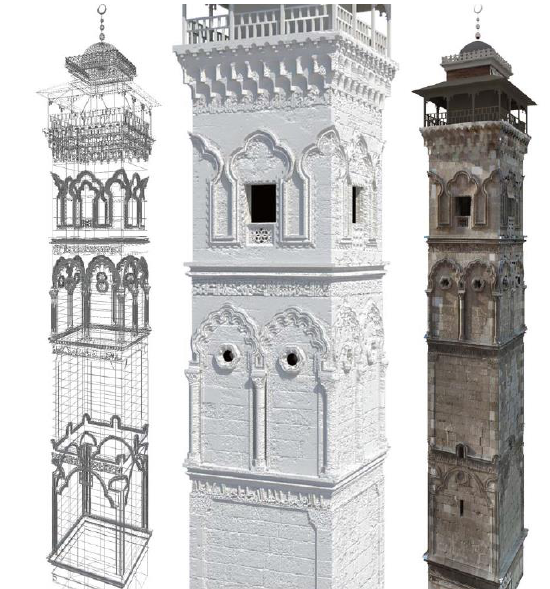
Figure 31 – The entrance gate (photomodelling by W.Wabeh)